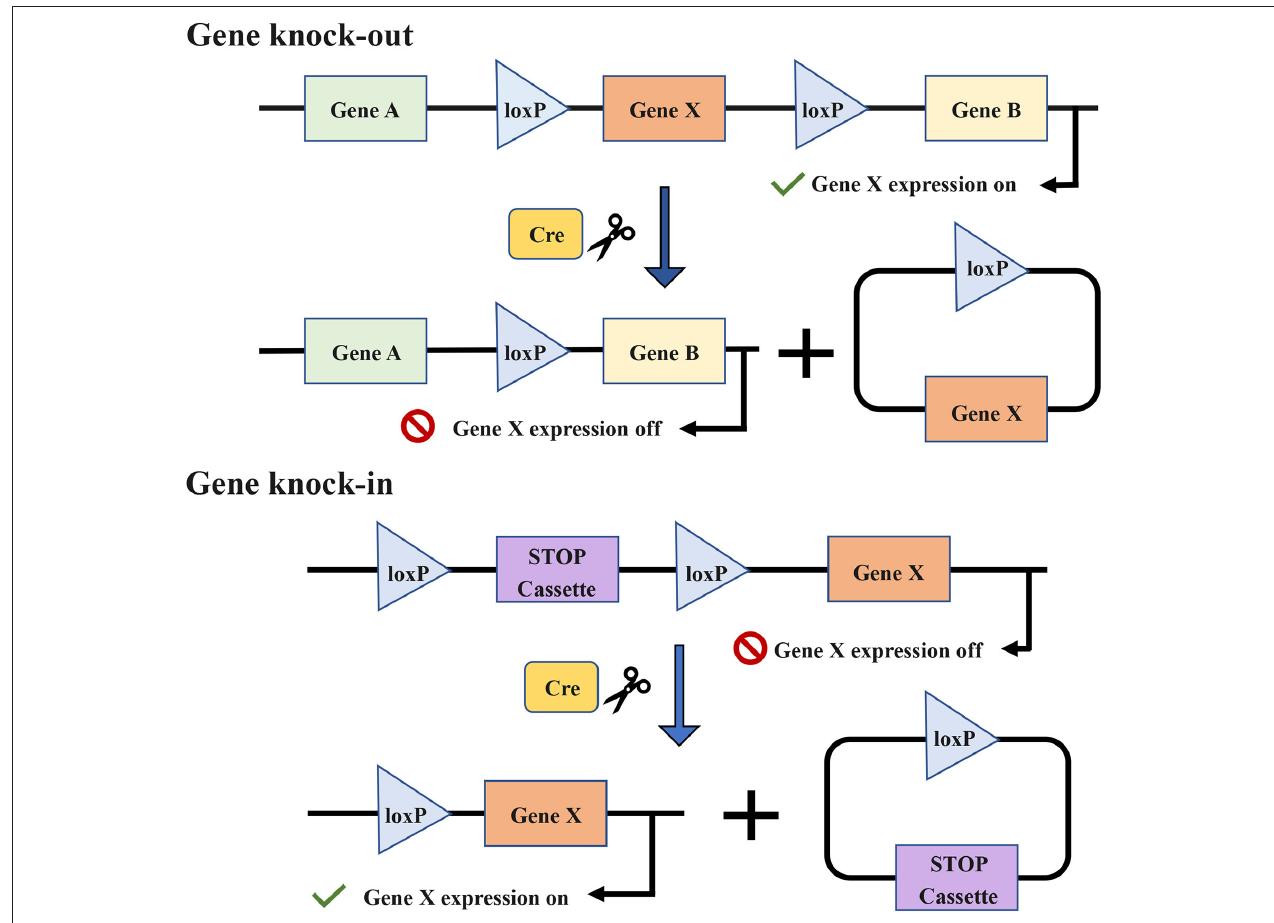
FIGURE 7 | The target gene X is knocked out or knocked in via the Cre-loxP recombinase system. Cre enzymes can respectively catalyze recombination between loxP sites oriented in the same direction and flank the target gene. The introduction of Cre recombinase can cause the knock-out of the gene X. The conditional knock-in of the gene X requires another sequence named strong translational and transcriptional termination (STOP), which can terminate the expression of gene X. When Cre recombinase is present, the STOP cassette can be removed and then gene X is